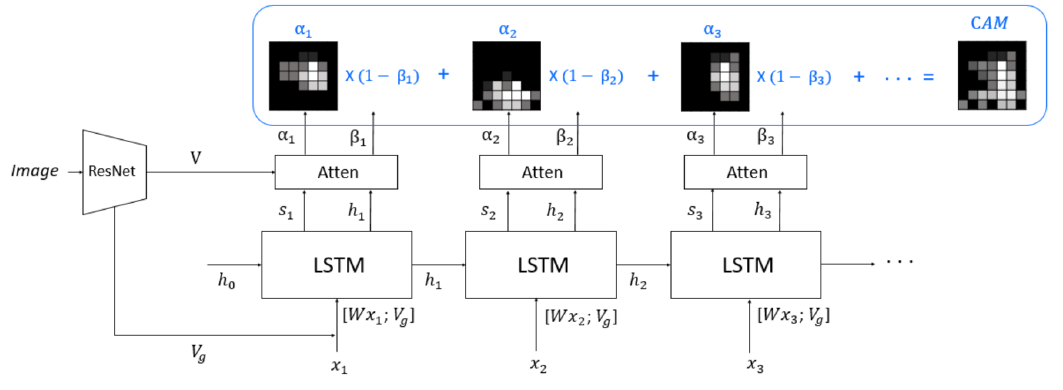
Figure 1. Illustration of the process generating a caption attention map (CAM). An attention